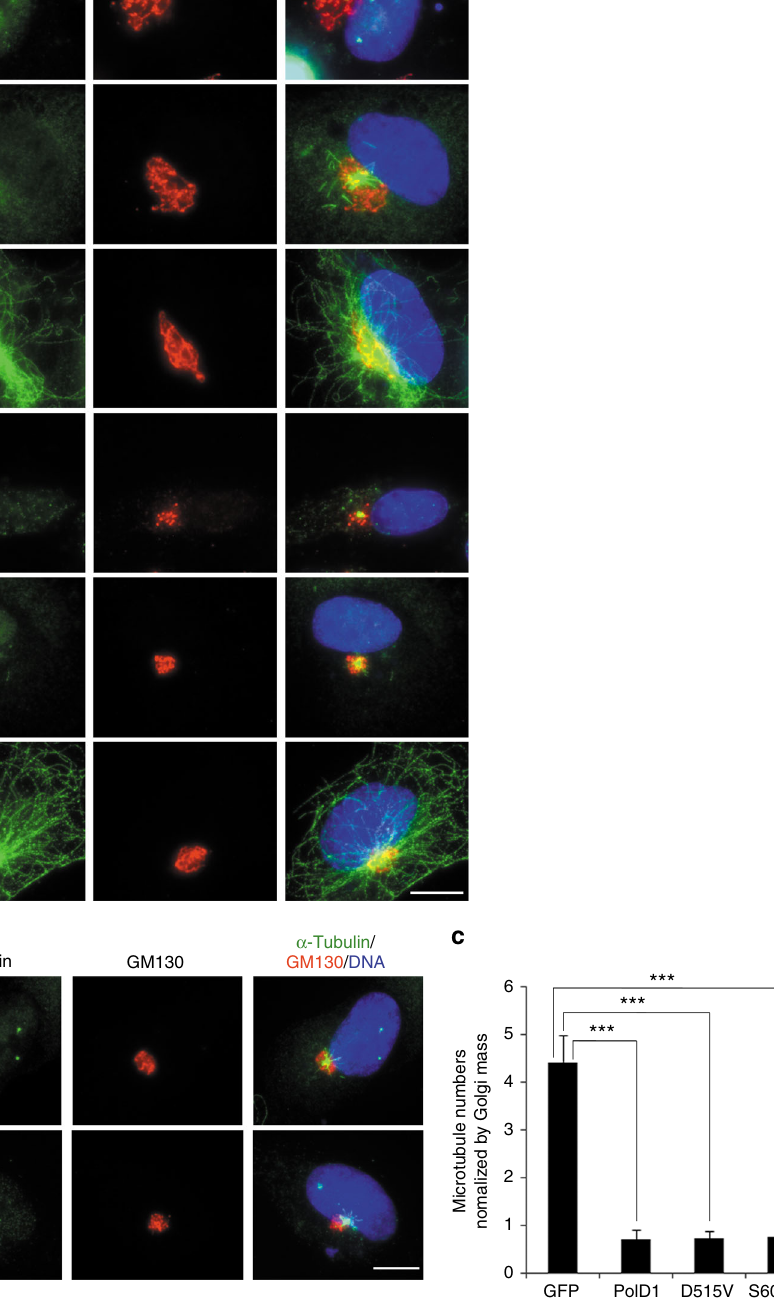
Fig. 3 PolD1 overexpression inhibits Golgi-associated microtubule regrowth. a , b RPE1 cells were transfected with GFP or GFP-PolD1 constructs and then subject to cold-induced microtubule depolymerization, after which microtubule regrowth was performed and examined through immunostaining. Hoechst 33258 was used to stain DNA. In the cells transfected with the PolD1 mutants D515V and S605del, microtubule regrowth was for 1.5 min ( b ). The images shown represent the phenotypes identi fi ed from three experiments (100 cells were analyzed per sample, and cells expressing GFP, GFP-PolD1, or PolD1 mutants at similar levels were selected for analysis). Scale bars , 10 μ m. c Golgi-associated microtubules at 1.5 min of regrowth were quanti fi ed. The quanti fi ed data were normalized by the Golgi mass, and are presented as means ± s.d. from three independent experiments; *** p < 0.001, two-tailed, unpaired student ’ s t